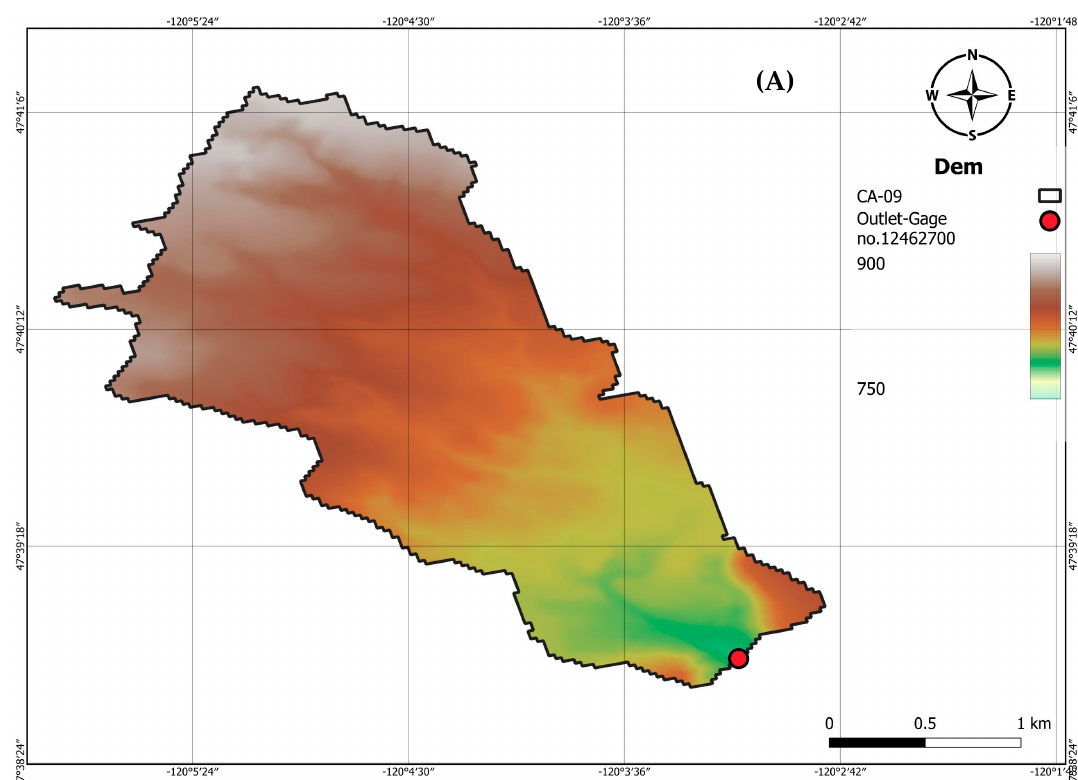
Figure A8. DEM and land-use maps for Catchment CA-08 ( A ) DEM, ( B ) NLCD 2019 land-use map, ( C ) LULC 2020-ESRI land-use map.